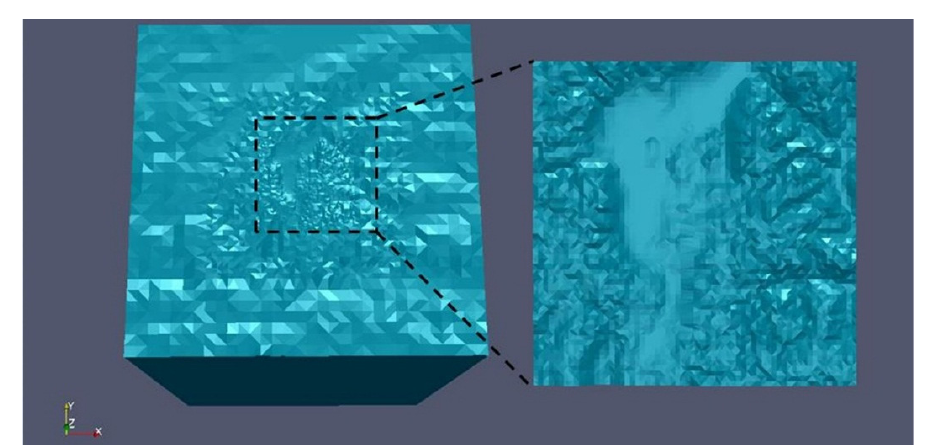
Figure 4. FEM of the Dangxiong earthquake deformation region with realistic topographic relief surface. Table 2. Fault rupture parameters of the 6 October 2008 Dangxiong M W 6.3 earthquake. Table 3. Continental crust configuration from the Crust 1.0